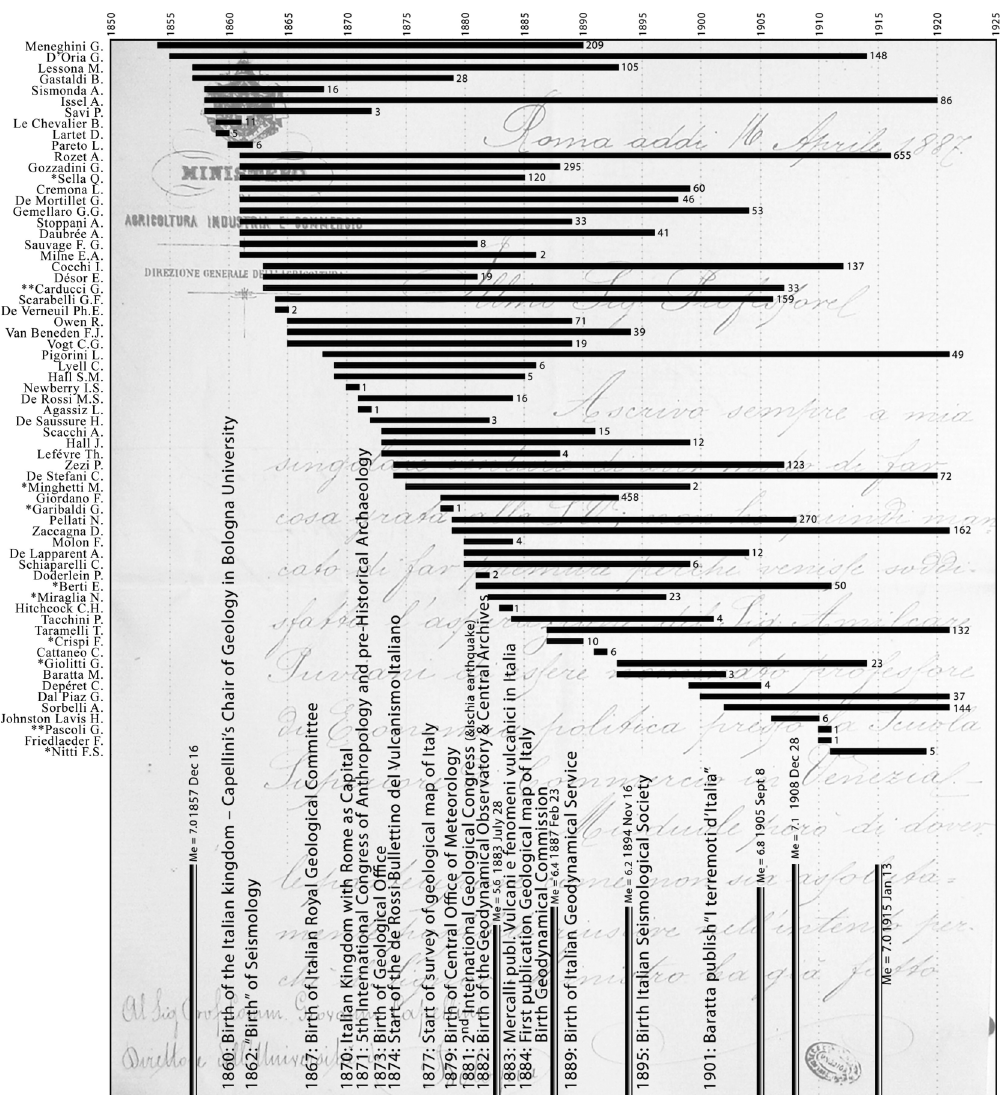
Fig. 3. Graphic representation of the period of the correspondence and the number of letters exchanged between G. Capellini and a select number of characters chosen as representatives of the scientific disciplines, the politics (*) and culture (**) of that times. Also indicated is the chronology of the scientific, political and cultural events that characterised the era in which Capellini lived and the main seismic events occurring in the time-span con-